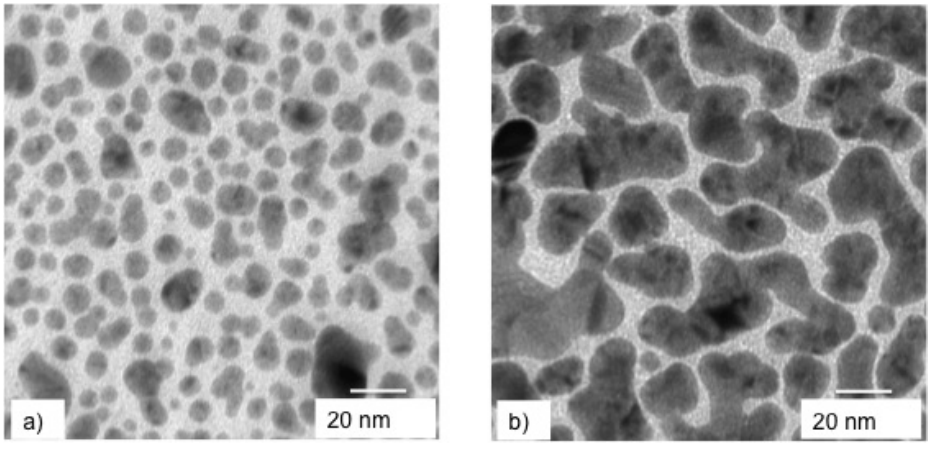
Figure 5. TEM images of the surface morphologies of two Ag samples deposited at a laser fluence of 2.8 J · cm − 2 with ablated mass per pulse of ( a ) 7.0 ng and ( b ) 16.4 ng.